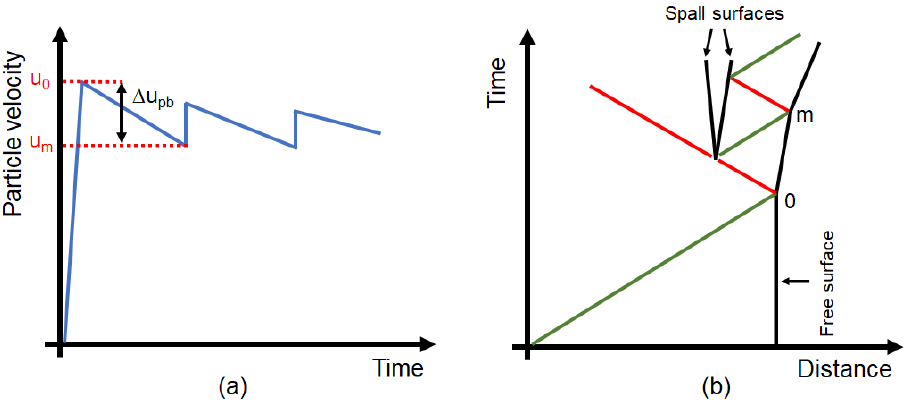
Figure 3. ( a ) Representation of the free surface velocity history. ( b ) Distance–time diagram of the compressive (green) and tensile (red) waves